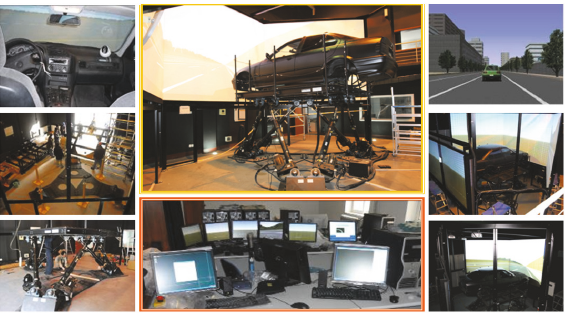
Figure 1: Driving